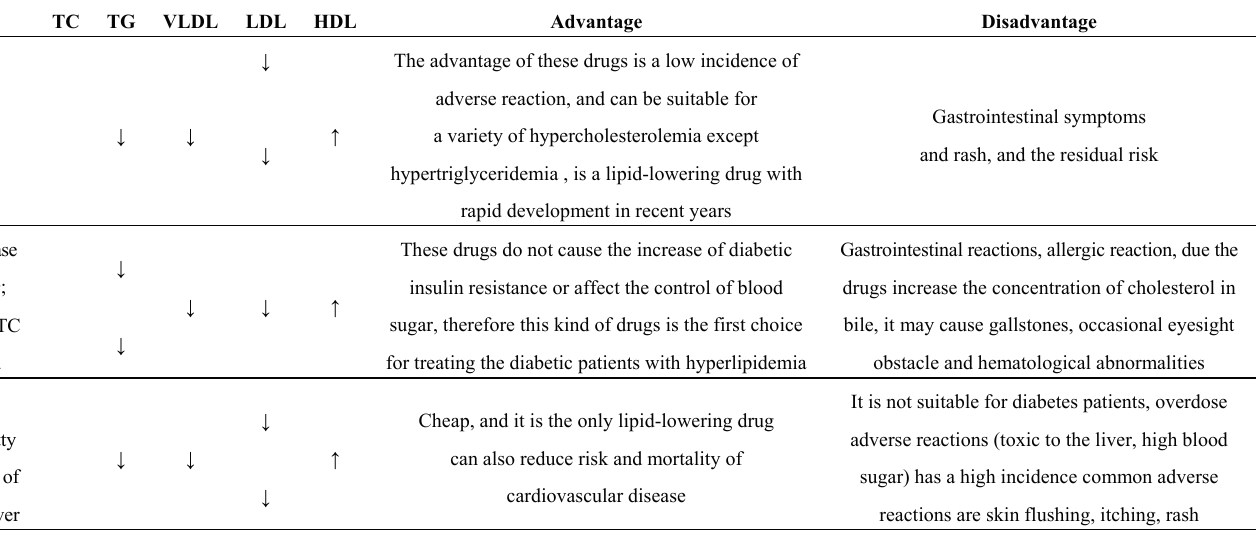
Table 1. Drugs of anti-hyperlipidemia in the current market. In recent years many cholesterol-lowering drugs are commonly used on the market, which mainly includes stains, fibrates, nicotinic acids, cholesterol absorption inhibitor and polyene unsaturated fatty acids.